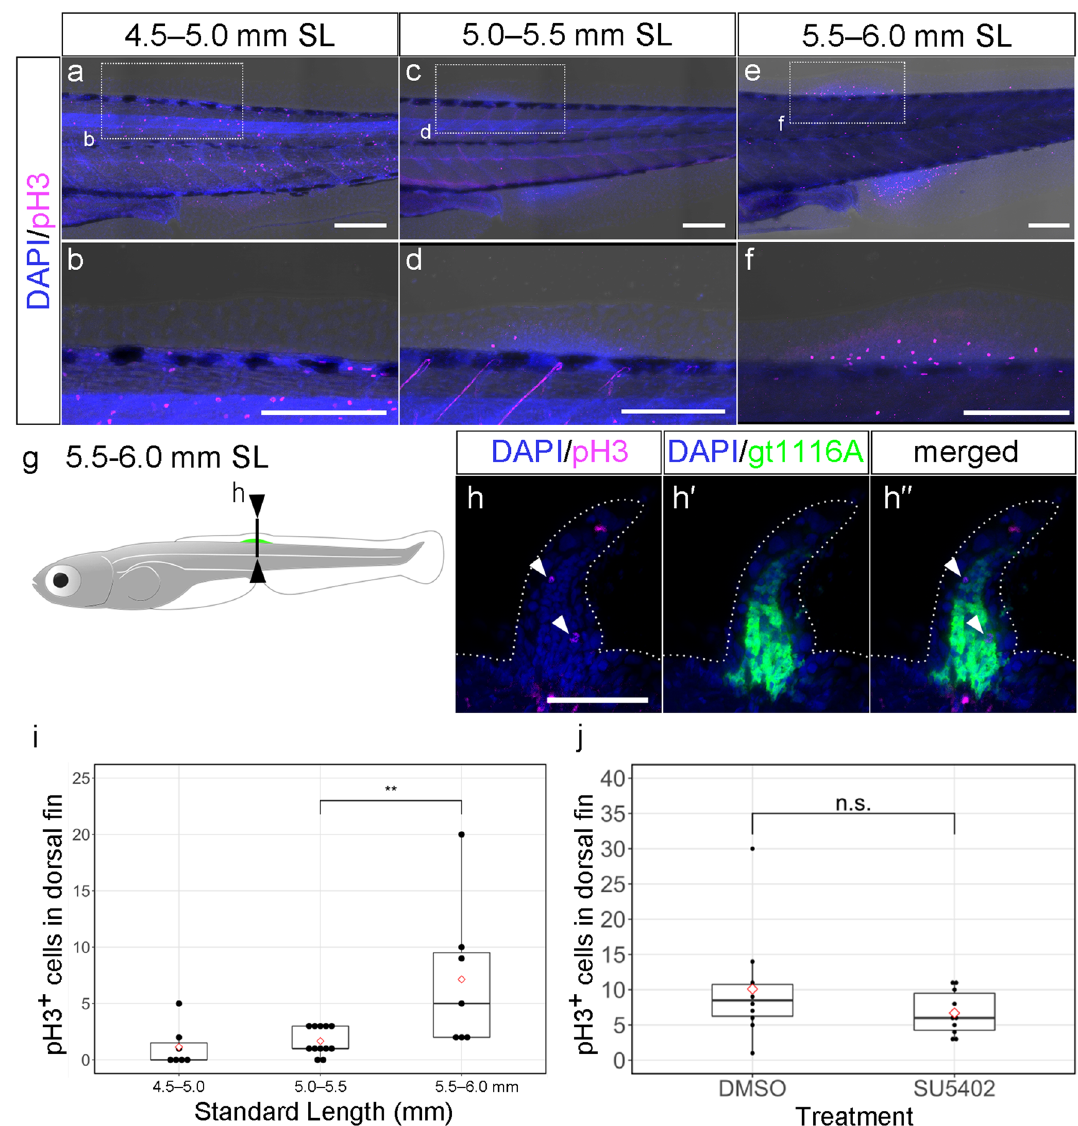
Figure 5. The expression pattern of phospho-histone-H3 in dorsal fin primordium. ( a – f ) Expression pattern of phospho-histone-H3 in the reducing LMFF area at 4.5–5.0 mm SL ( a , b ), 5.0–5.5 mm SL ( c , d ), and 5.5–6.0 mm SL ( e – f ). The lower panels ( b , d , f ) are magnified views of the dashed rectangles in the upper panels ( a , c , e ), respectively. ( g , h’’ ) The expression pattern of UAS:EGFP of the gt1116A line and phospho-histone-H3 in dorsal fin primordium at 5.5–6.0 mm SL. Black lines in ( g ) indicate levels of the section shown in ( h – h’’ ). Arrowheads in ( h , h” ) indicate phospho-histon-H3 signals. ( i ) Boxplots of phospho-histone-H3-positive cells in dorsal fin development along with the growth of the body. In ( i ), more than half of the 4.5–5.0 mm SL zebrafish samples, phospho-histone-H3-positive cells were not detect. Thus, we conducted statistical analysis only between 5.0–5.5 mm SL and 5.5–6.0 mm SL. ( j ) Boxplots of phospho-histone-H3-positive cells in dorsal fin development under SU5402 treatment. The proportions in ( i ) and ( j ) were calculated from the number of pH3-positive cells in dorsal fin primordium. Whiskers in ( i ) and ( j ) show maximum and minimum values within 1.5 times the interquartile range. Boxes show the median and 25th and 75th percentiles. The P value in ( i ) and ( j ) is the result of Brunner-Munzel test ( P = 0.009701) and the result of Welch’s t test ( P = 0.2272), respectively. Scale bars in ( a – f ) and those in ( h ) indicate 200 μm and 50 μm, the reduction of the LMFF is not associated with dorsal fin formation. Instead, the LMFF reduction appeared to occur together with an increase in body size. In other words, other cellular and developmental processes could be responsible for dorsal fin formation during ontogeny. What kinds of cellular developmental mechanisms play a role in dorsal fin formation? From examining the appearance of the dorsal fin primordium, our findings show that the dorsal fin primordial mesenchyme, which expresses UAS:EGFP in the gt1116A line and develops into the adult fin skeleton (Fig. 4), emerges simultaneously with the LMFF protrusion (Fig. 1). Due to gt1116A trapping prdm16 , we suggest that developmental mechanisms